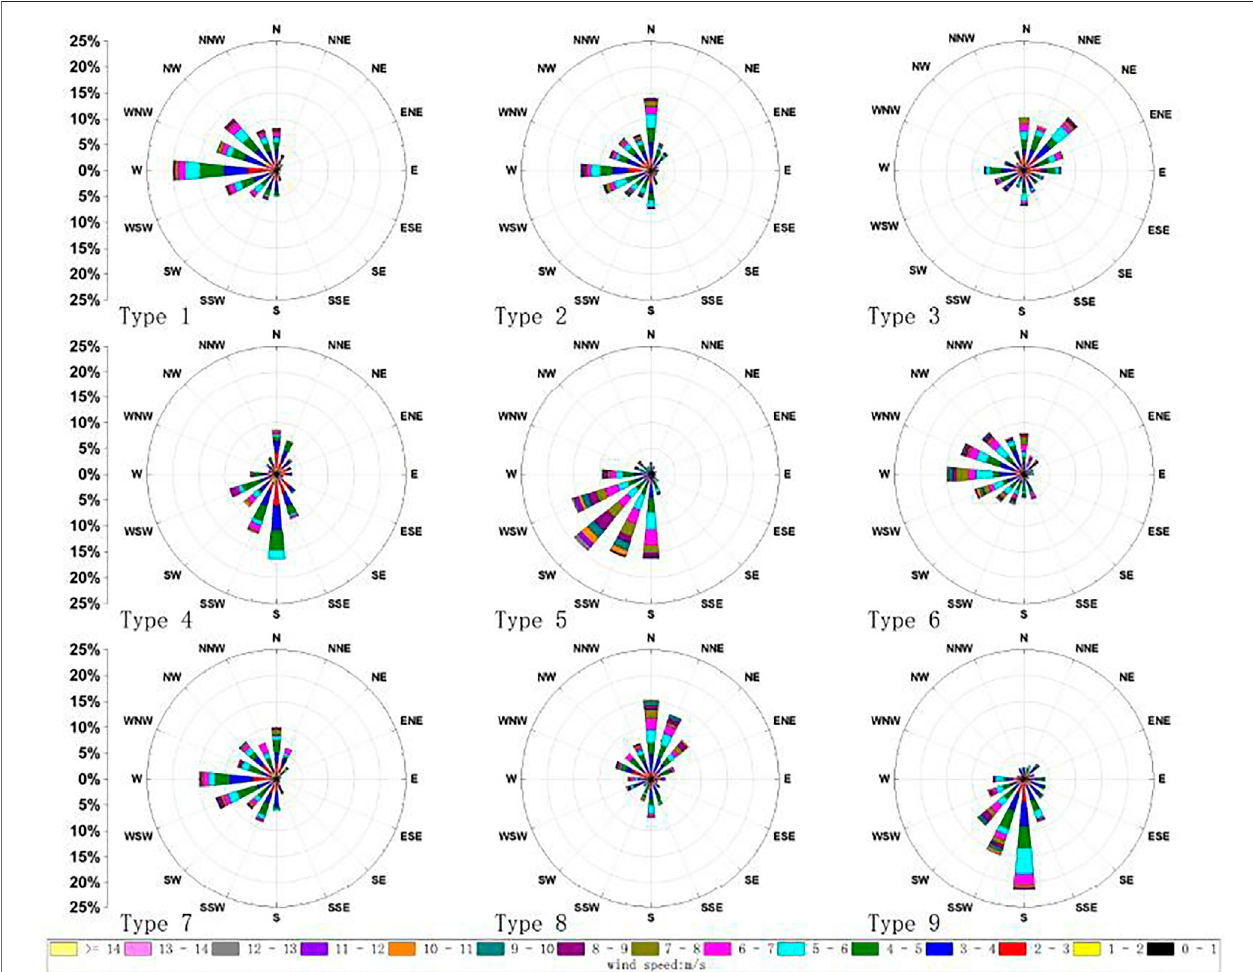
FIGURE 4 | A wind rose of the local wind fi eld corresponding to the nine circulation types in Northeast China during 2016 – 2020.